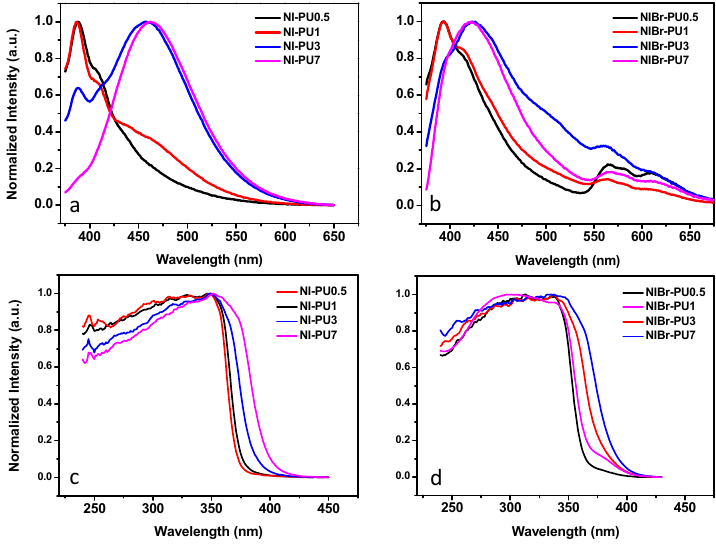
Figure 5. Steady-state emission spectra of different NI ( a ) and NIBr ( b ) concentrations in WPUs under air ( λ ex = 365 nm); Absorption spectra of different NI ( c ) and NIBr ( d ) concentrations in WPUs.